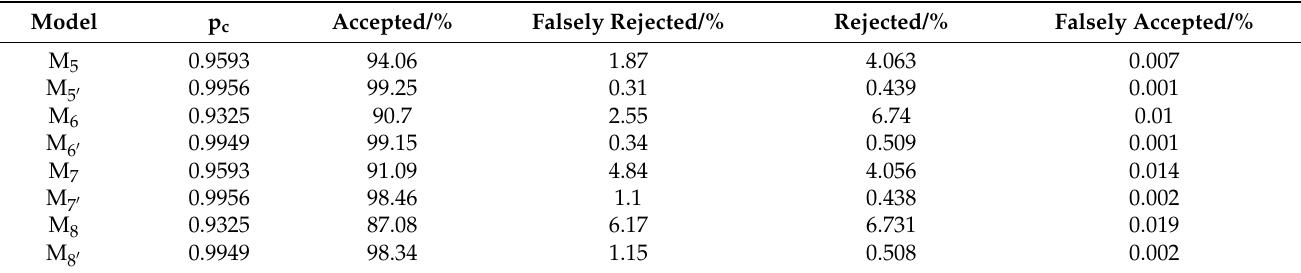
Figure 4. ( a ) Consumer’s risk and ( b ) producer’s risk, models M 5 , M 6 , M 7 and M 8 . According to the conformance probability, there are 95.93% conformed and 4.04% non-conformed measurements for models M 5 and M 7 . For models M 6 and M 8 , there are 93.25% conformed and 6.75% non-conformed measurements. The results for the percentage of accepted, rejected, falsely accepted, and falsely rejected measurements are shown in Table 3. Table 3. Conformance probabilities for the pipe junction.